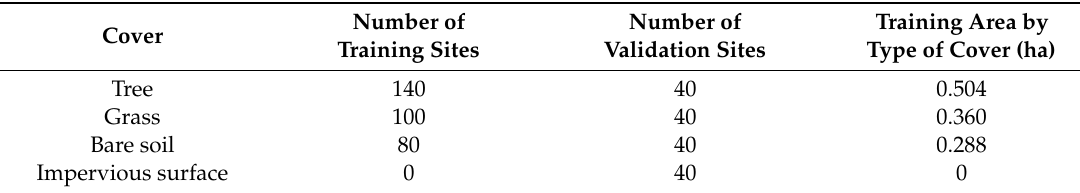
Table 2. Training and validation sites by type of cover.